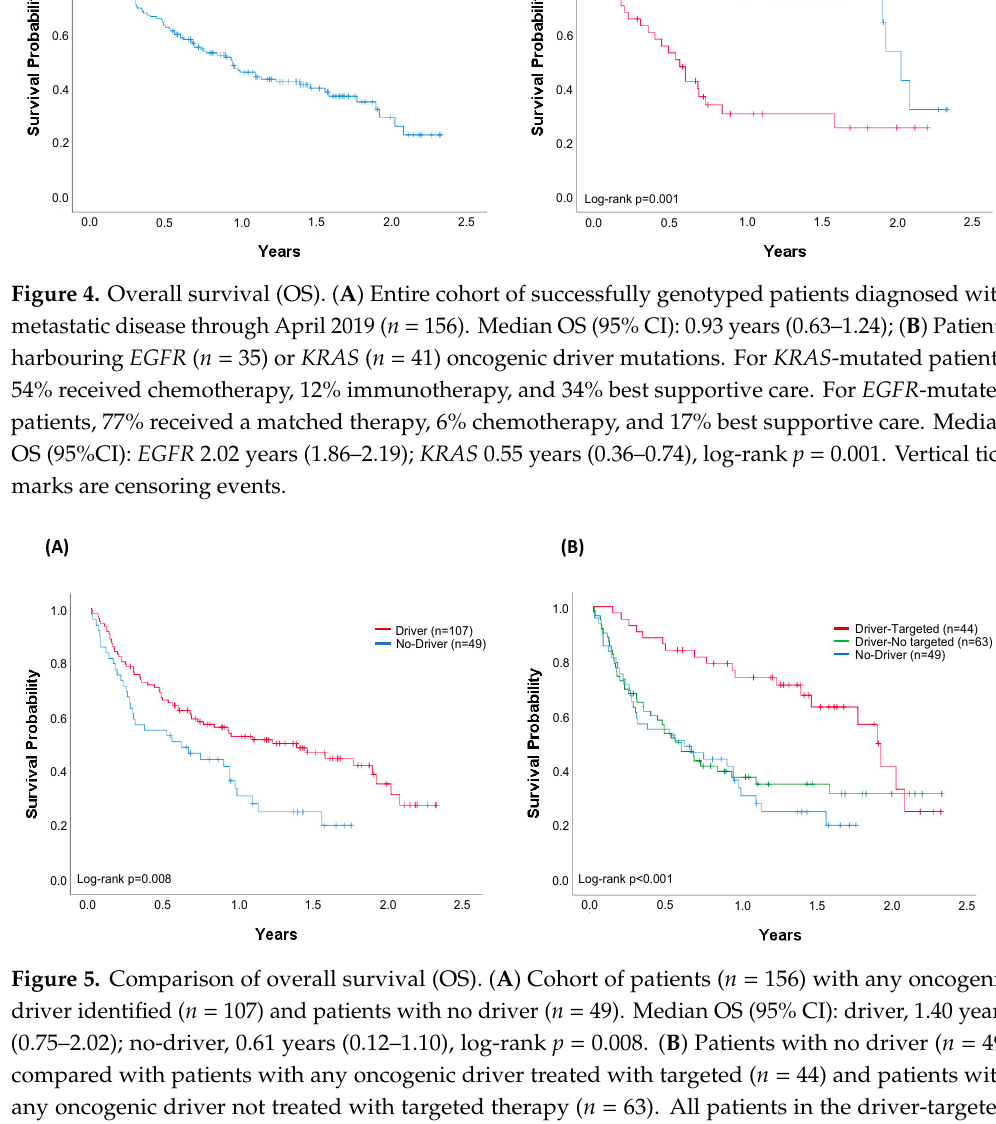
Figure 5. Comparison of overall survival (OS). ( A ) Cohort of patients ( n = 156) with any oncogenic driver identified ( n = 107) and patients with no driver ( n = 49). Median OS (95% CI): driver, 1.40 years (0.75–2.02); no-driver, 0.61 years (0.12–1.10), log-rank p = 0.008. ( B ) Patients with no driver ( n = 49) compared with patients with any oncogenic driver treated with targeted ( n = 44) and patients with any oncogenic driver not treated with targeted therapy ( n = 63). All patients in the driver-targeted group were treated with a genotype-directed therapy. No-driver and driver-no targeted patients were treated with chemotherapy (51% and 48%), immunotherapy (12% and 11%), and best supportive care (37% and 41%), respectively. Median OS (95% CI): driver-targeted 1.90 years (1.69–2.10); driver-no targeted 0.59 years (0.39–0.79); no driver 0.61 years (0.12–1.10), log-rank p < 0.001. Vertical tick marks are censoring events.